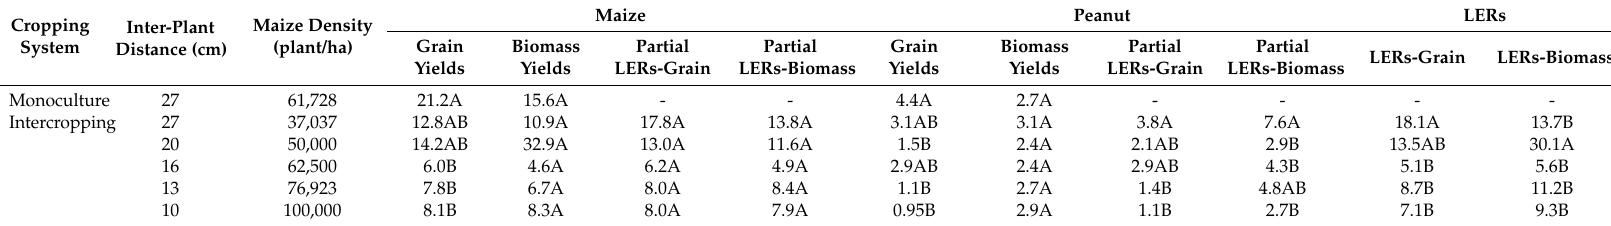
Table 7. Community stability of productivity (grain/biomass yields and/or partial/total land equivalent ratios (LERs)) as affected by different cropping systems and maize densities in the maize/peanut intercropping